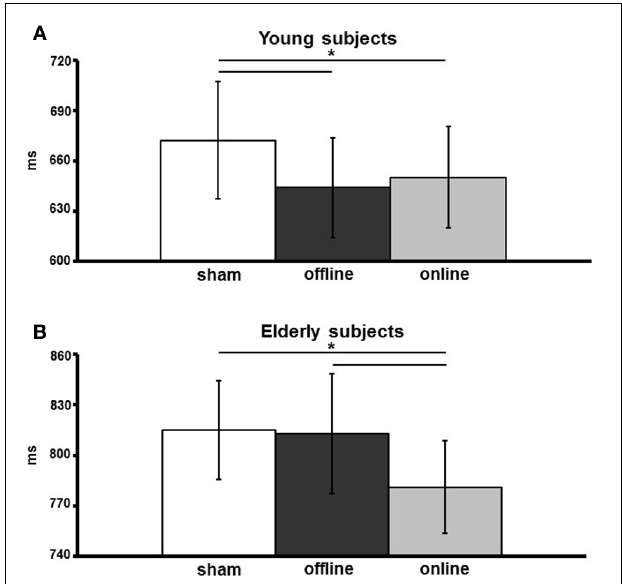
FIGURE 3 | Verbal reaction times (vRTs) of young (A) and elderly (B) participants, for the three stimulation conditions (sham, online, offline). The data are expressed in milliseconds along the ordinate. An asterisk indicates a p < 0 . 05. The error bars represent the mean standard